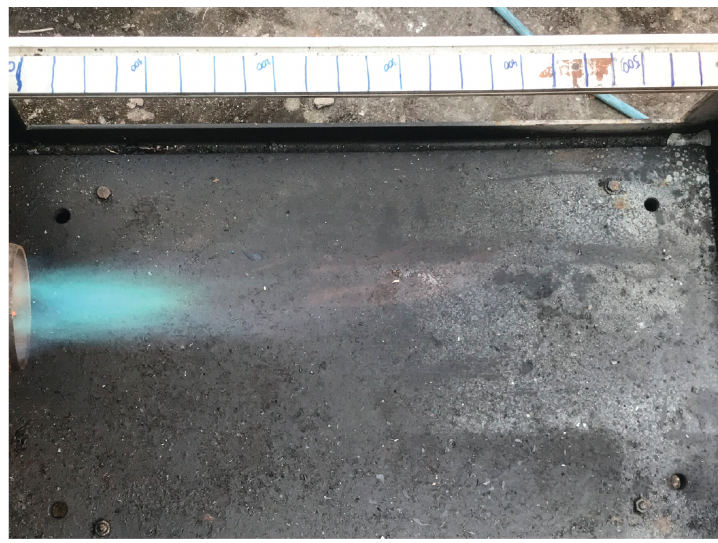
Figure 9. Propane combustion in OILON